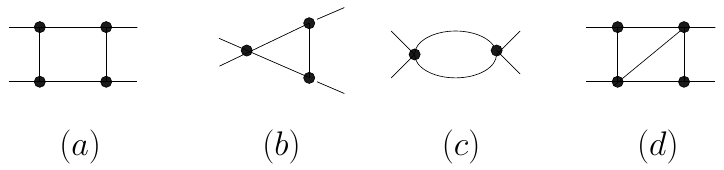
Figure 1 . (a) The one-loop box graph; (b) one of the once-reduced graphs of (a) containing the anomalous thresholds; (c) one of the twice-reduced graphs of (a) containing the normal thresholds; (d) the acnode graph. Black circles denote nonlocal